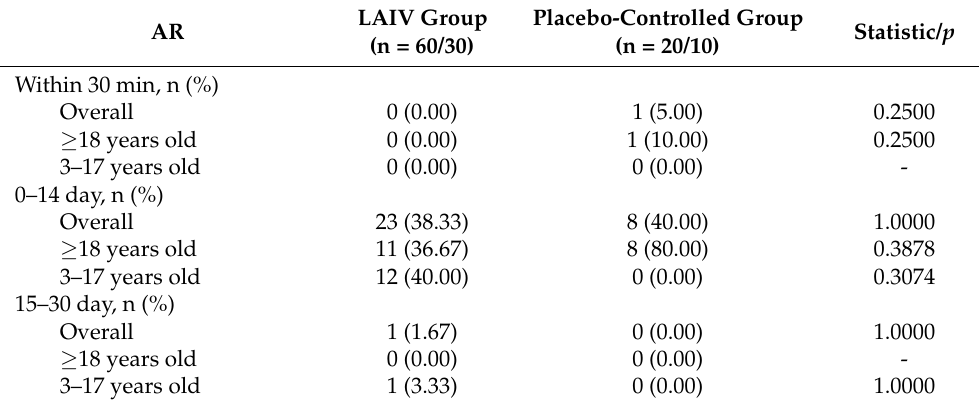
Table 4. Analysis of the time of occurrence of adverse reactions